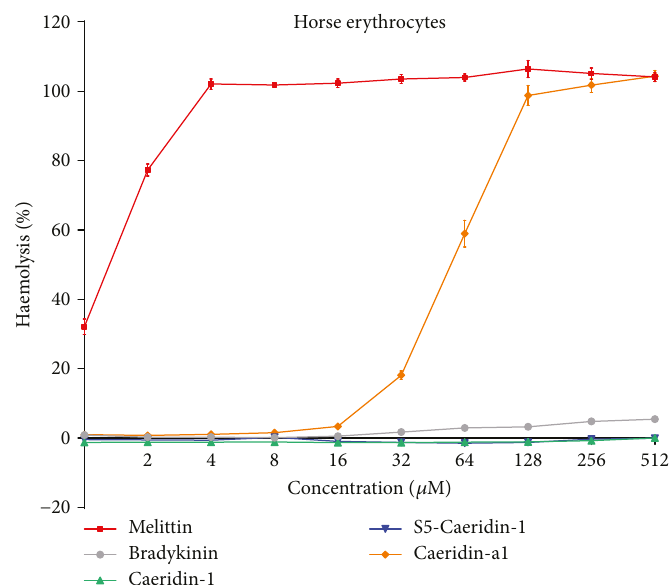
Figure 11: Haemolytic activities of synthetic Caeridin-1, S5-Caeridin-1, Caeridin-a1, melittin, and bradykinin. The level of haemolysis tested on horse red blood cells was calculated in comparison with the maximum haemolysis control (1% Triton X-100-treated). The error bar represents SEM of three independent experiment determinations and each experiment with fi ve